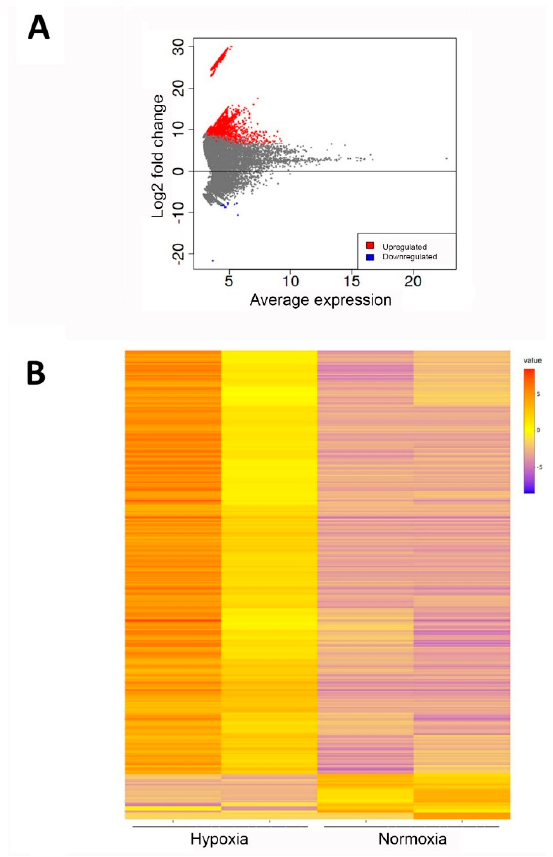
Figure 3. Transcriptome analysis of ASC-EVs after hypoxic versus normoxic culture conditions. ( A ) MA plot of transcript expression changes 48 h after induction of hypoxia, showing significant changes in red (up-regulated) and blue (down-regulated). ( B ) Heatmap of differentially expressed transcripts (blue = significantly down-regulated, red = significantly up-regulated).